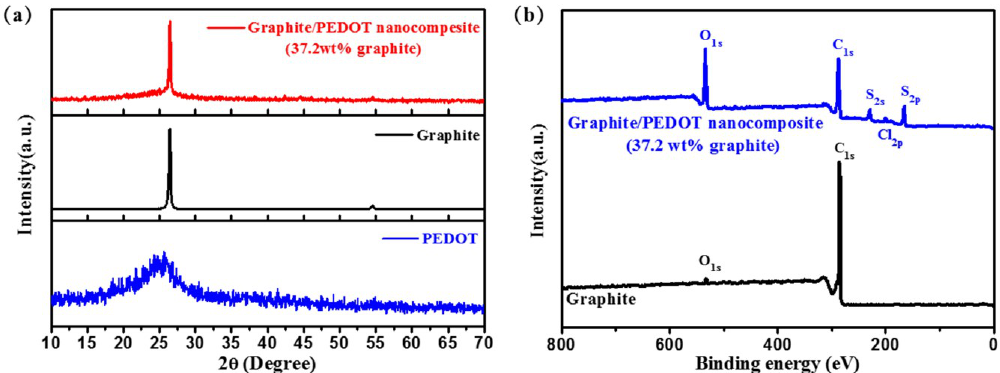
Figure 2. ( a ) X-ray power diffraction (XRD) patterns of PEDOT, graphite, and graphite/PEDOT nanocomposite with 37.2 wt % graphite, and ( b ) X-Ray photoelectron spectroscopy (XPS) of graphite and graphite/PEDOT nanocomposites with 37.2 wt % graphite.